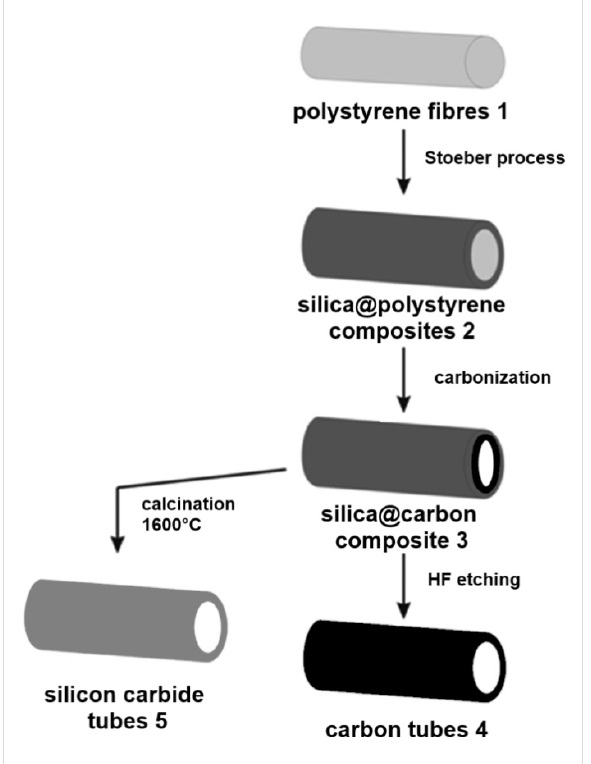
Figure 1: Schematic drawing showing the formation pathways leading to carbon tubes (4) and silicon carbide tubes (5) starting from electro- spun polystyrene fibres